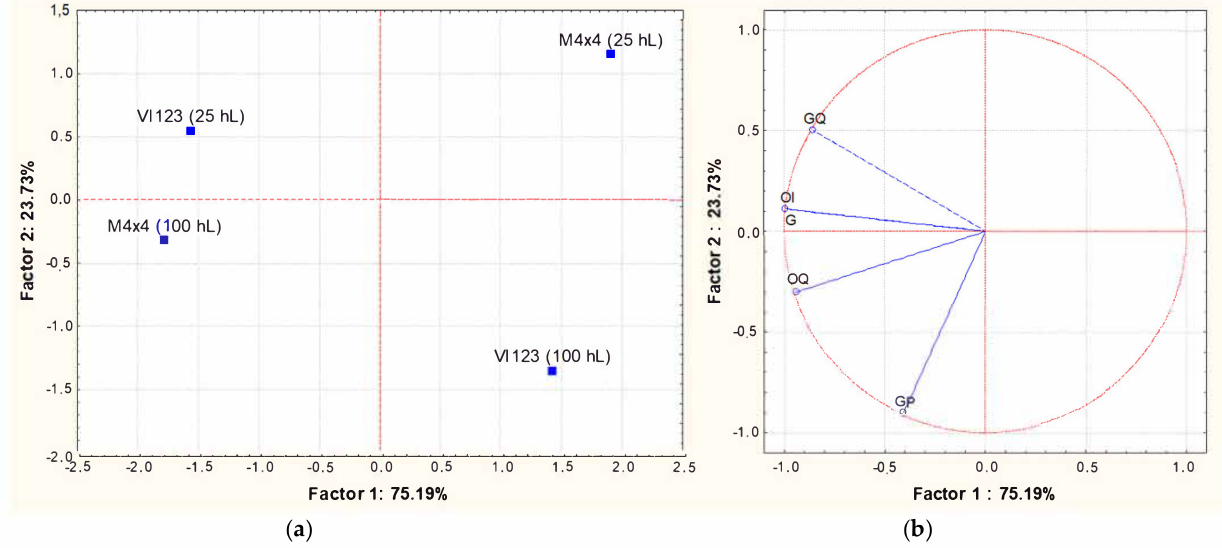
Figure 8. Principal Component Analysis carried out on sensorial characterizations of wines obtained inoculating the indigenous strain VI 123 and the commercial strain BM4 × 4 in 25 or 100 hL of grape must. The experimental approach is the one proposed by the OIV [36]. ( a ): similarity map determined by Principal Component (Factor) 1 and 2; ( b ): projection of the variables on the factor plane. Variables: OF: olfactory frankness; OI: olfactory intensity; OQ: olfactory quality; GF: gustatory frankness; GI: gustatory intensity; GQ: gustatory quality; GP: gustatory persistence; G: Global.